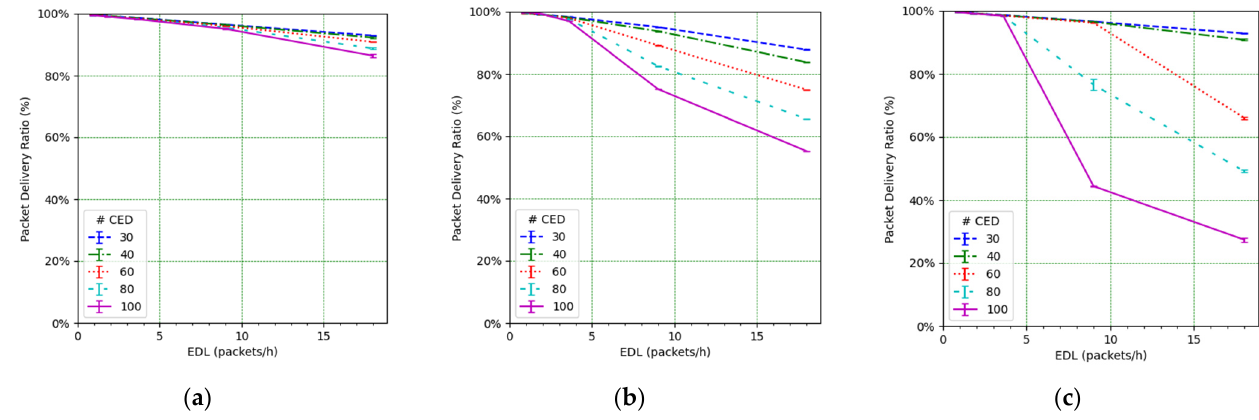
Figure 14. PDR vs. EDL for ( a ) SFM1, ( b ) SFM2, and ( c )